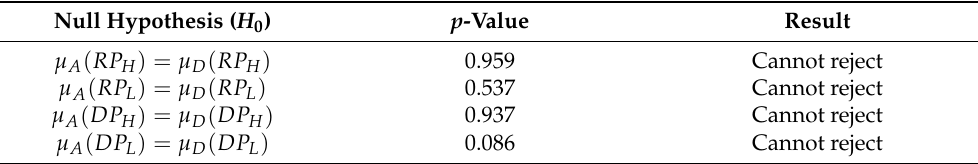
Table 6. Statistical test results for Scenario A and Scenario D